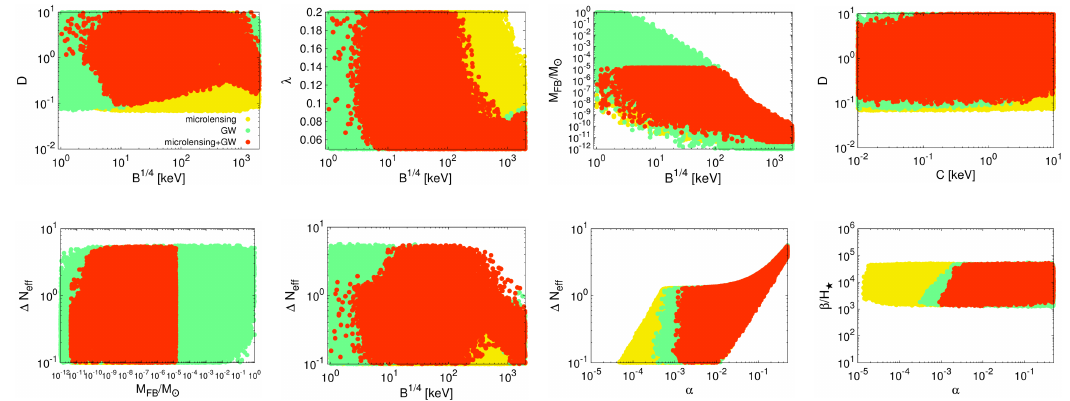
Figure 7 . The regions of parameter space that yield a microlensing signal at Subaru-HSC and a gravitational wave signal at SKA/THEIA/ µ Ares. In the red regions correlated GW and microlens- ing signals can be detected.